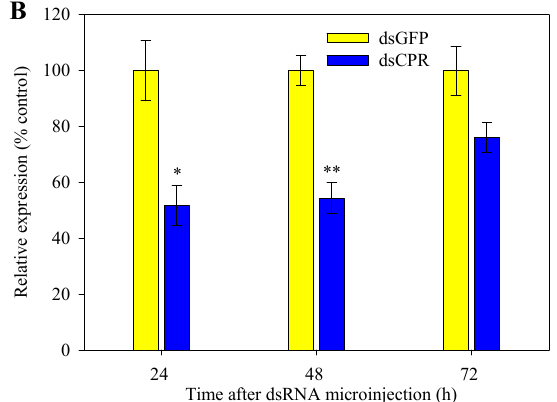
Figure 5. RNA interference (RNAi)-mediated silencing of SlCPR in fifth-instar larvae. Larvae were microinjected with dsCPR or dsGFP (control). RNA was isolated at indicated time points after microinjection. Expression levels of SlCPR in the midgut ( A ) and fat body ( B ) were then determined by RT-qPCR. The expression levels of SlCPR were normalized using β -actin and EF1 as reference genes. Each RT-qPCR reaction for each sample was performed in three technical replicates and three biological replicates. Data indicate means ± SE. Asterisks indicate significantly reduced expression levels in SlCPR -silenced larvae as compared to the control group (Student’s t -test, * p < 0.05,** p < 0.01, *** p < 0.001).